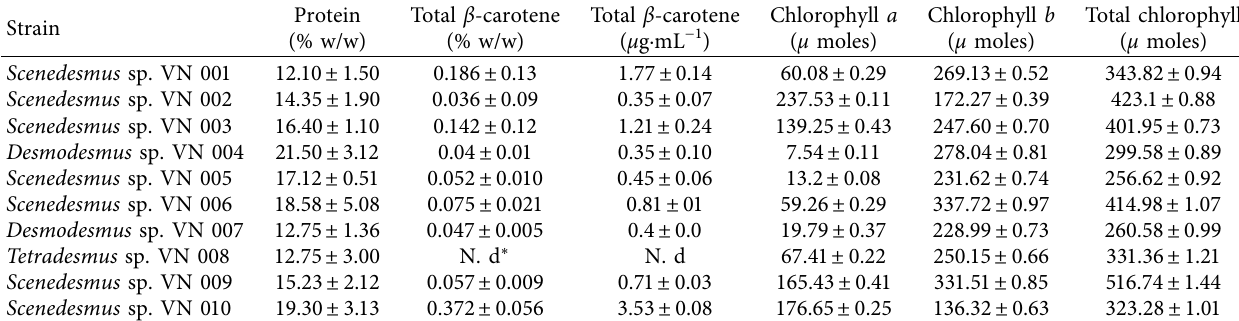
Table 4: Biomass composition analysis of selected microalgal strains.